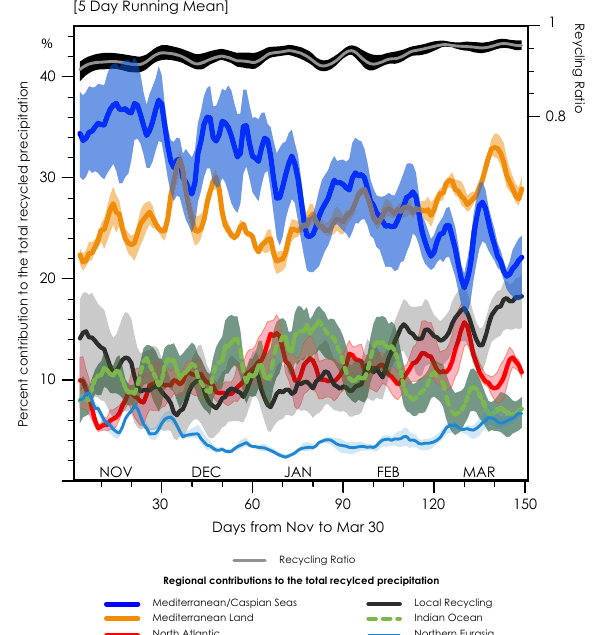
Fig. 3 Climatological sub-seasonal variability of the recycled precipitation from individual source regions. Total recycling ratio (top line; right y-axis; unitless) and percent contribution from individual source regions to the total recycled precipitation (bottom six lines; left y-axis; %) at sub-seasonal (5-day running mean) timescale, averaged over the study region shown as black in Fig. 1a. The lines represent the average of three reanalyses, and the shaded area represents the range across them. Regional contributions to the total recycled precipitation are only shown for regions with contributions exceeding >6% during the